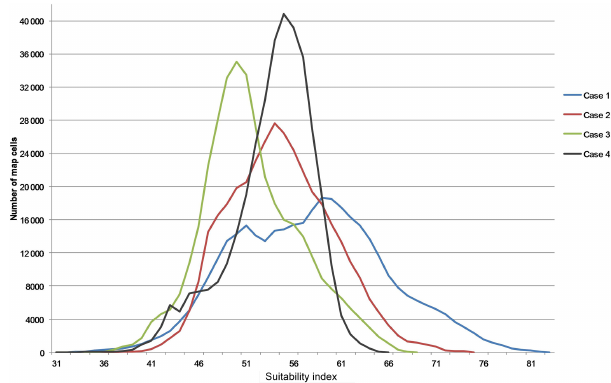
Figure 8. Number of map cells for each case of sensitivity